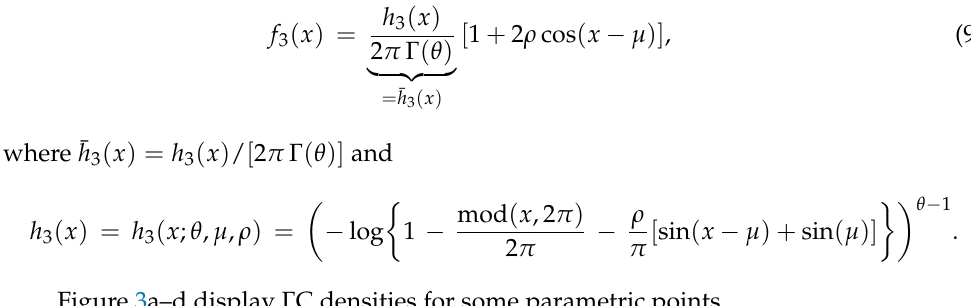
Figure 3a–d display Γ C densities for some parametric points.